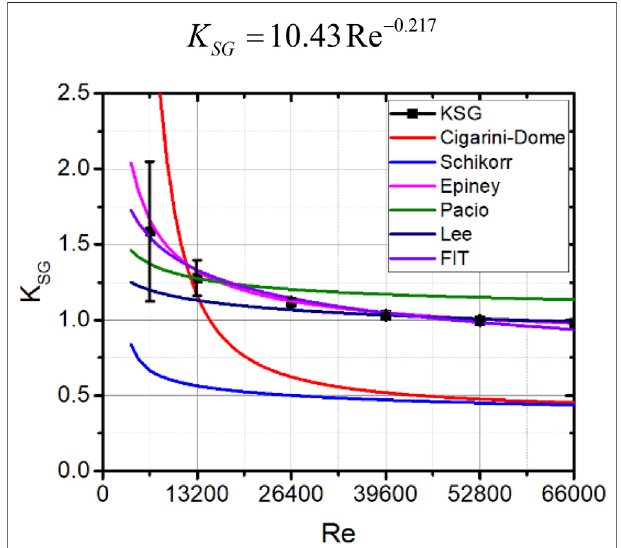
FIGURE 6 | Spacer grid resistance